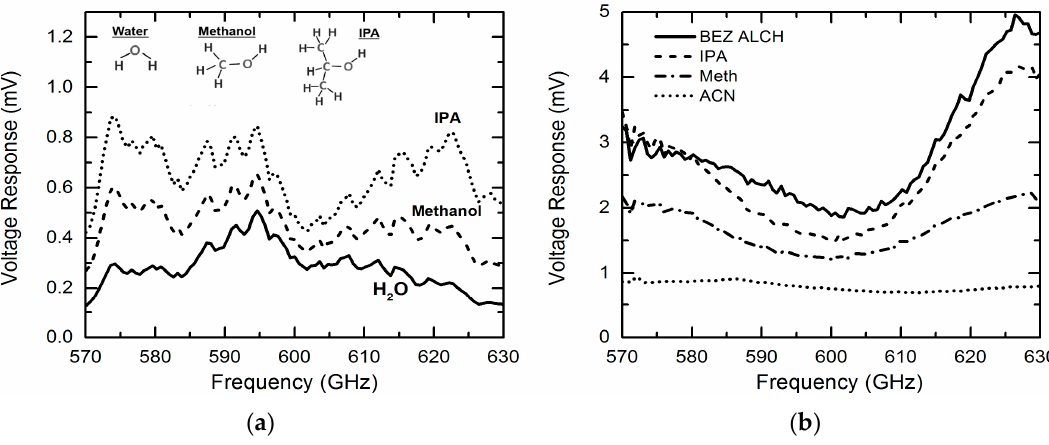
Figure 5. ( a ) Raw data of the THz spectra responses for isopropylalcohol (IPA), Methanol and water; ( b ) Comparison of normalized (to water) THz spectra responses for a variety of chemicals (Benzyl alcohol (BEZ ALCH), isopropylalcohol (IPA), methanol (Meth) and acetonitrile (ACN)), demonstrating the system’s capability for discriminating different chemicals.